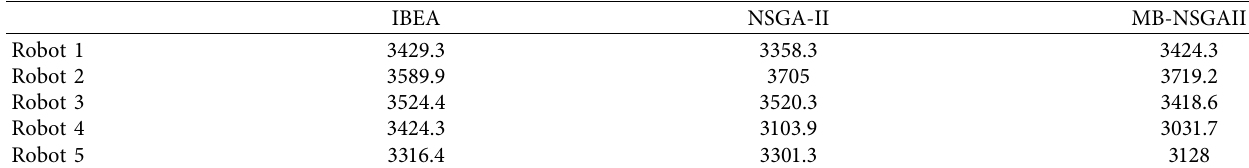
Table 8: Average time consumption of robots when using 5 robots for 100